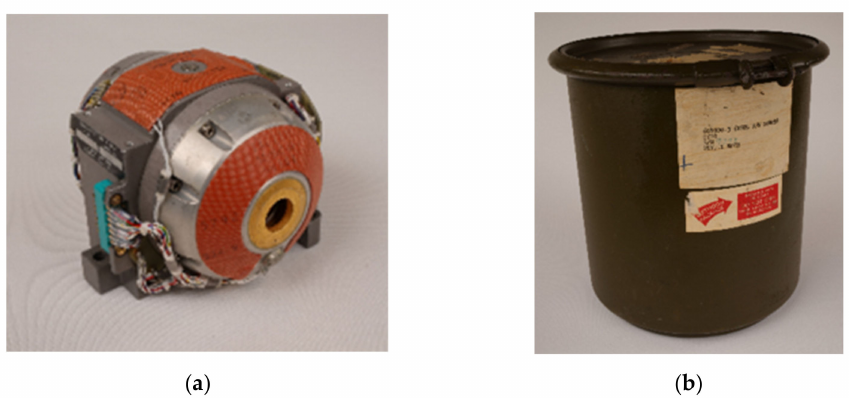
Figure 27. The Gyro G200 of the LN3 Inertial Platform: ( a ) Gyro G200; and ( b ) G200 transportation